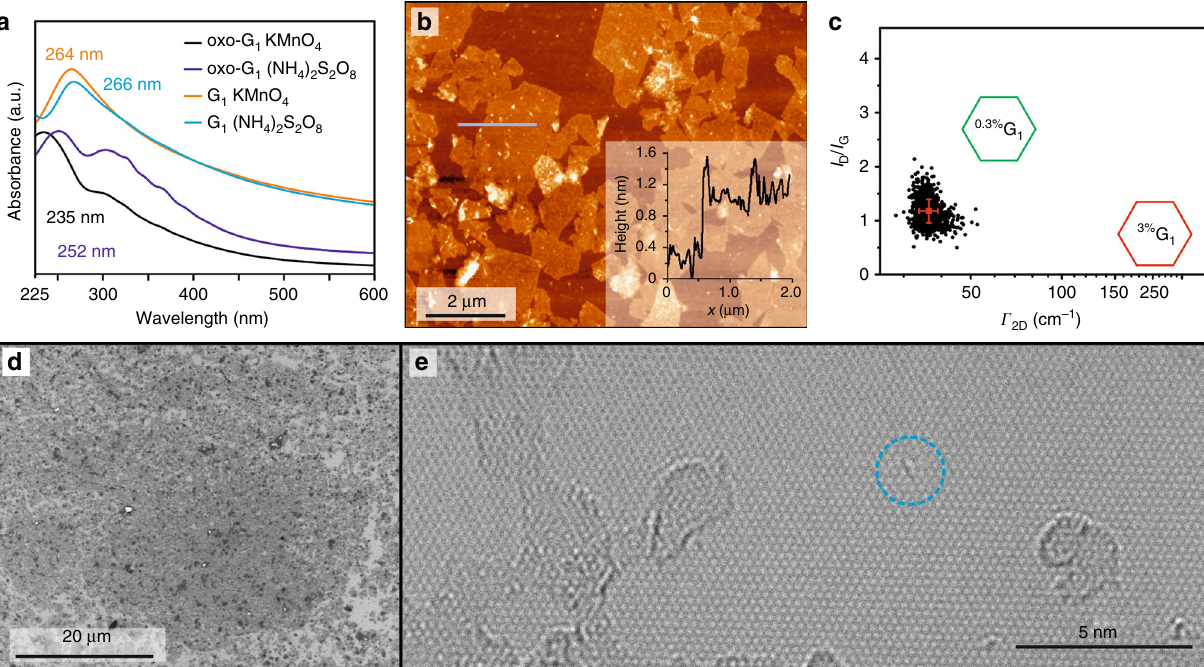
Fig. 4 Characterization of the exfoliated graphene. a UV – Vis spectra of oxo-G 1 and their corresponding reduced species. b AFM image of the same fi lm and height pro fi le along gray line. c SRS results of the graphene fi lm (density of defects about 0.025% (black)) compared to graphene derived from oxo-G 1 with a density of defects of 0.3% (green) and about 3% (red), respectively. d Optical microscope image of a fi lm of fl akes of graphene prepared by LB technique on 300 nm SiO 2 surface. e TEM image shows the resolved carbon lattice of graphene next to amorphous impurities; lattice defects are mainly point defects (for a large-scale image see Supplementary Figs. 4 and